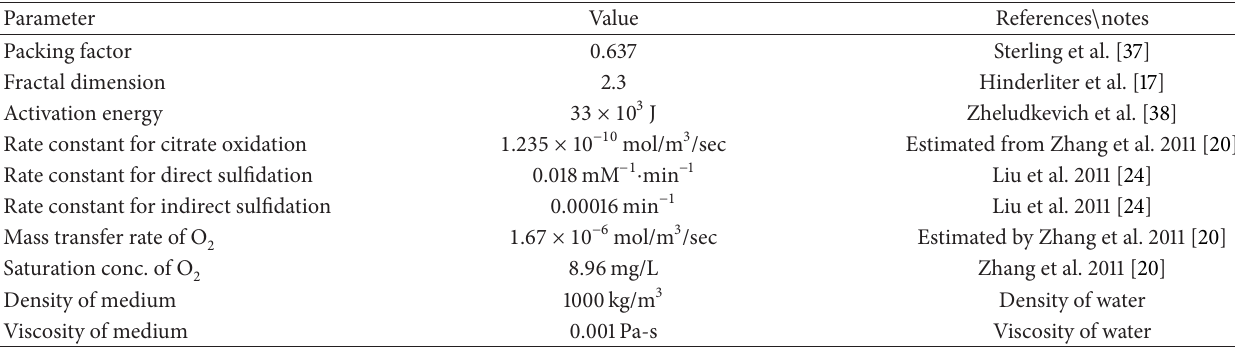
Table 2: Parameter values used in the ADSRM